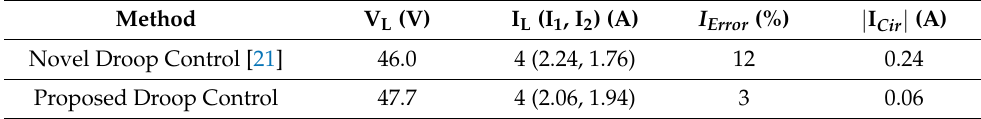
Table 9. Comparison of experimental results of different methods considering different cable resistances.